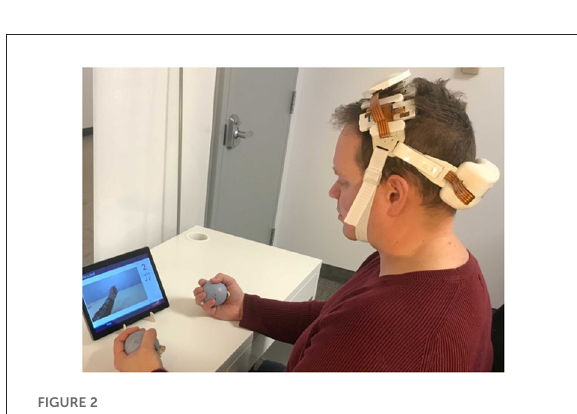
FIGURE2 Illustration of the experimental set up for the present study. Participants wore the prototype fNIRS headband while a first-person video of a fist squeezing task was played on a tablet. Participants were asked to follow along with the movements in the video as best they were